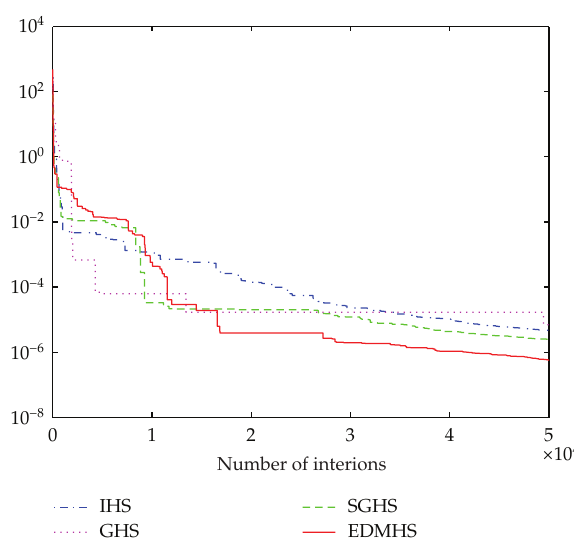
Figure 5: Convergence of Powell quartic